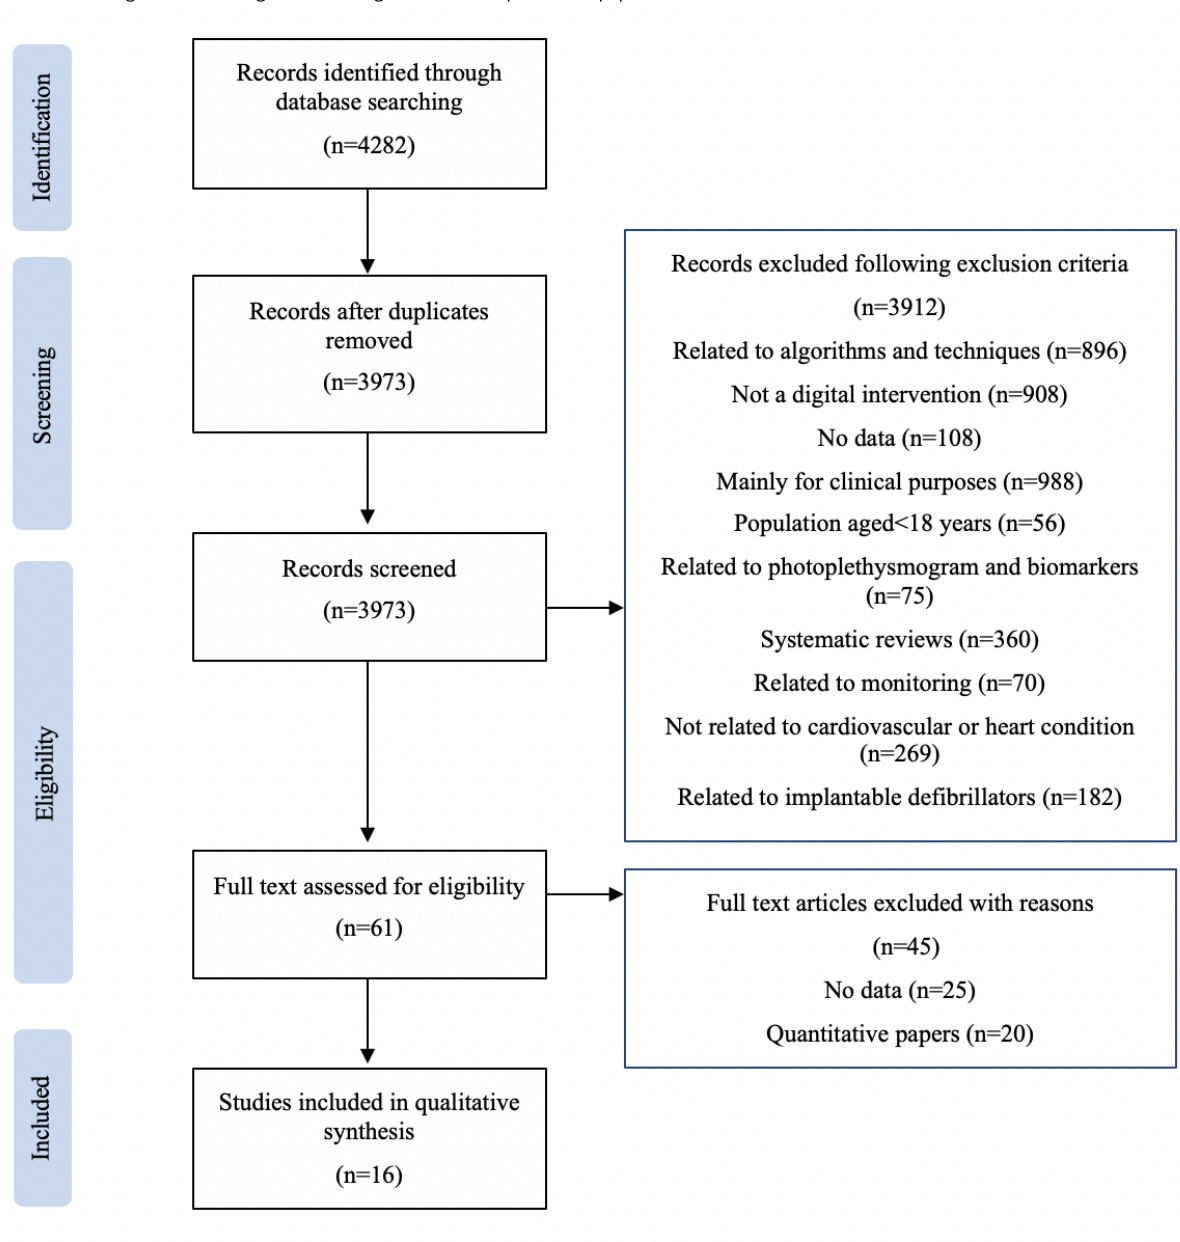
Figure 1. Flow diagram illustrating the screening and selection process of